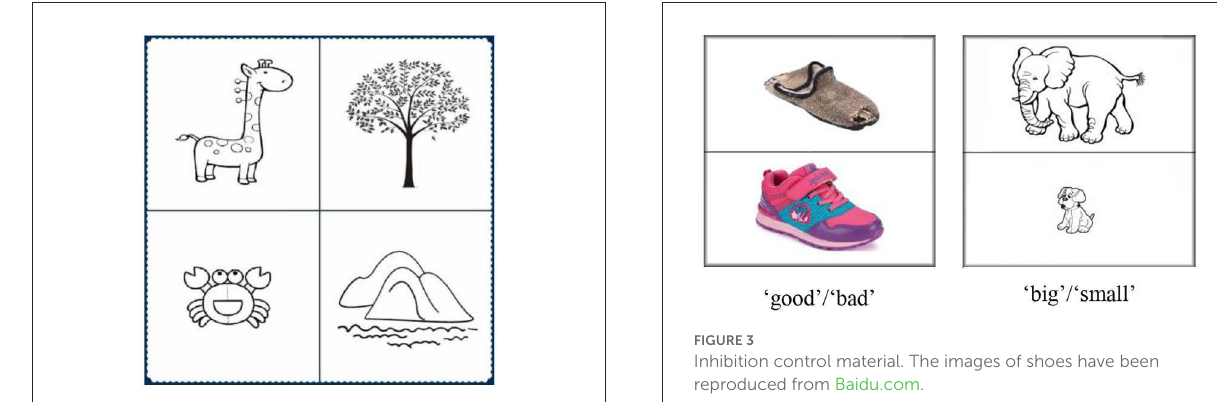
FIGURE2 Picture materials adapted from PPVT.